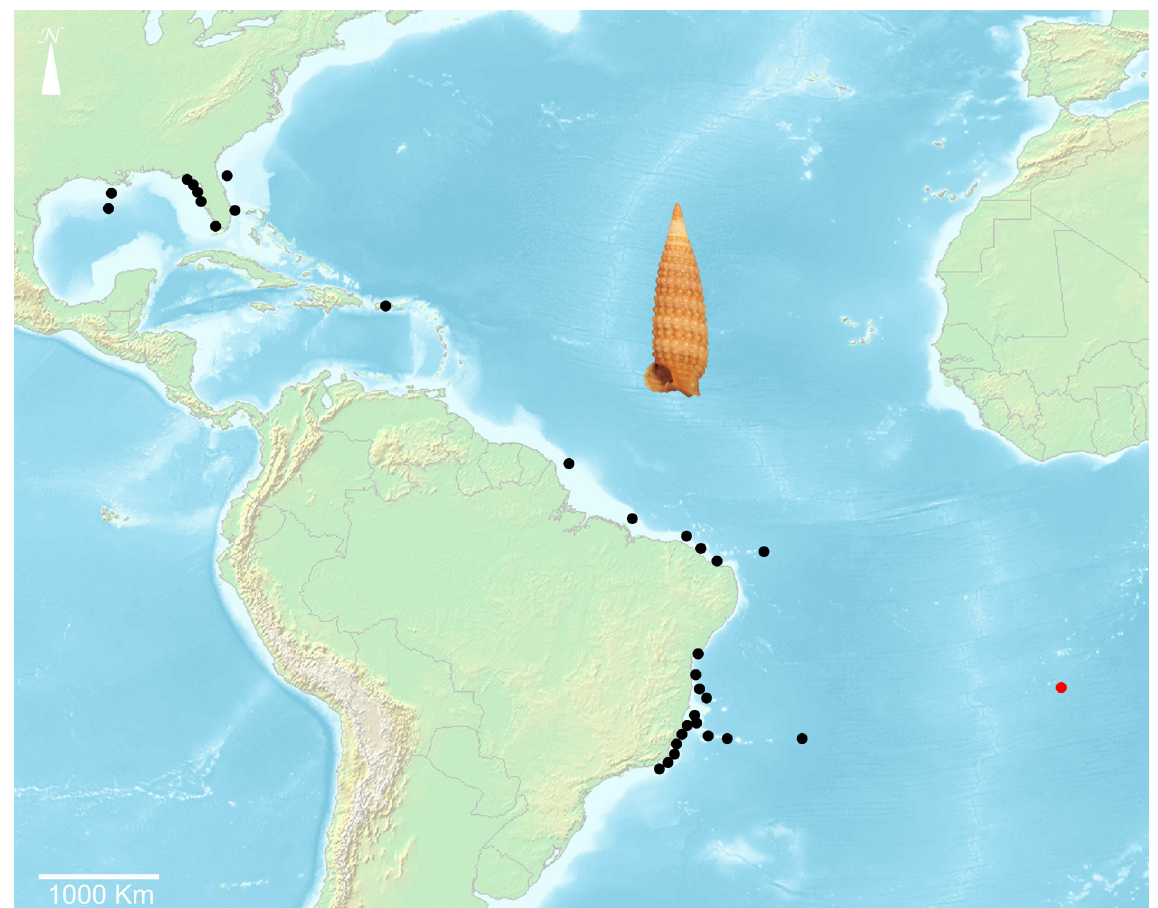
Fig. 76. Distribution map of Triphora atlantica Smith, 1890; red circle = type